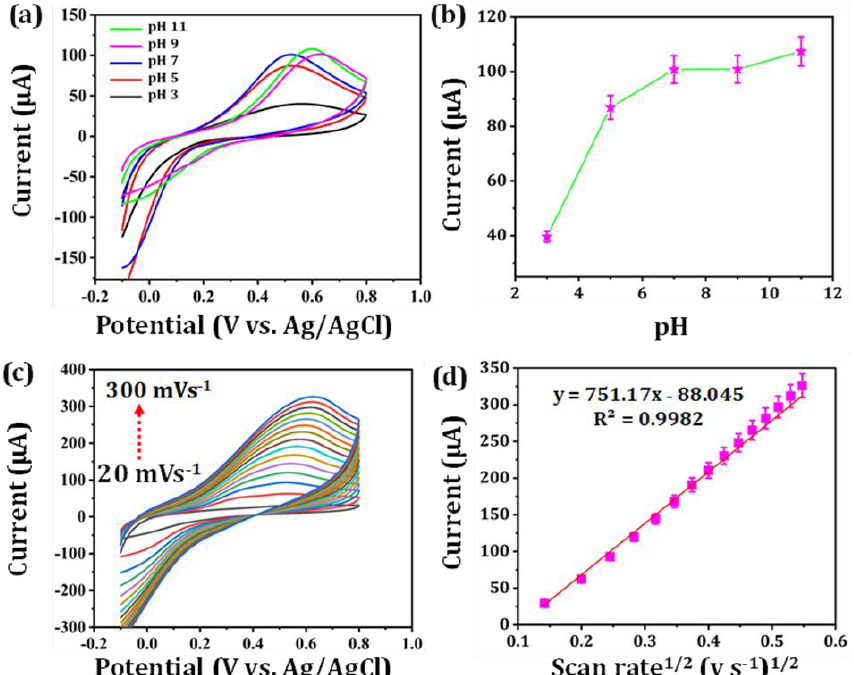
Figure 4. ( a ) CV curves of 100 µ M sulfide at the PtNi/SPE in 0.05 M PB at pHs from 3.0 to 11.0 at a scan rate of 0.05 V s − 1 , ( b ) plot of pH vs. current response, ( c ) CV response of PtNi/SPE for 100 µ M of sulfide at various scan rates (0.02–0.3 V s − 1 ), ( d ) linear plot of I pa of sulfide vs. square root of scan rate (Vs −1 ) 1/2 .